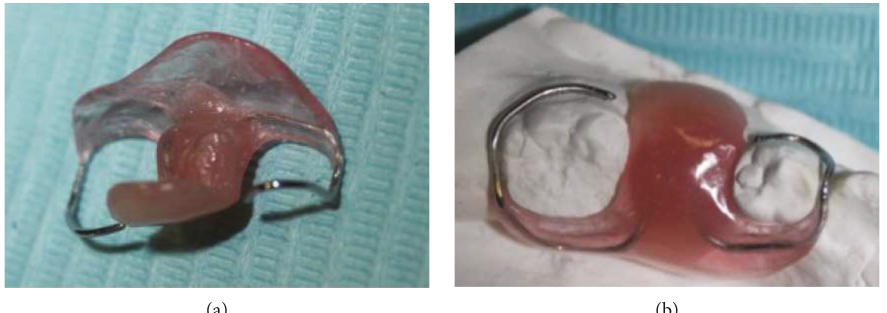
Figure 5: The acrylic resin obturator to maintain the surgical opening during healing.